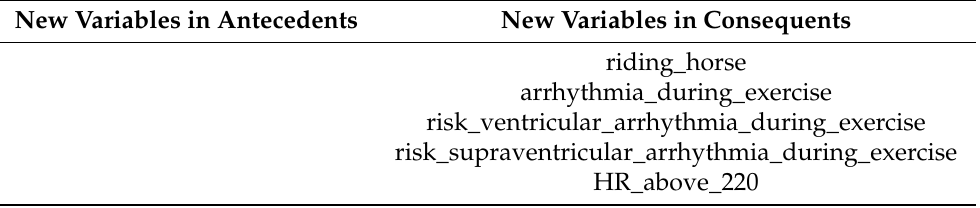
Table 5. Subsystem III (diagnoses): IIIb: murmurs (third level input data and conclusions/ask for more